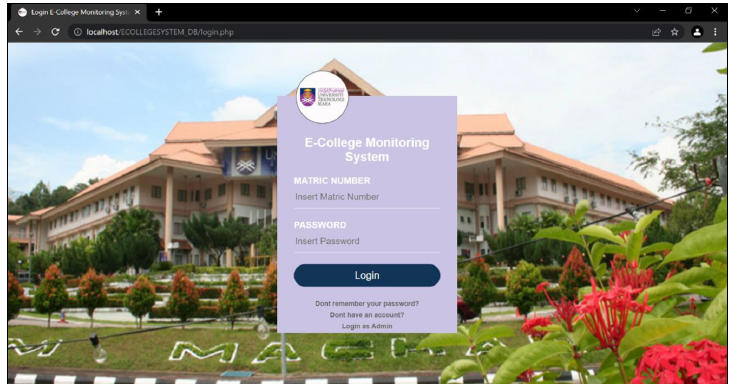
Figure 2. Data Flow Diagram (DFD).